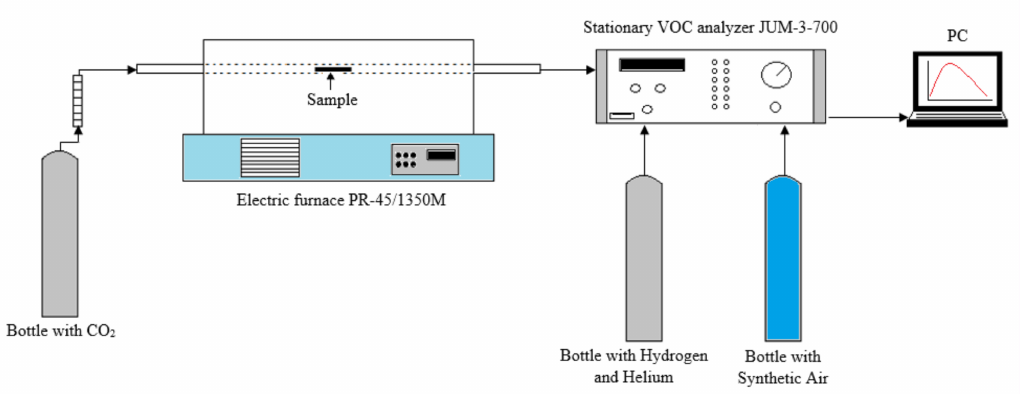
Figure 3. Diagram of an installation for determining the emissions of total volatile organic